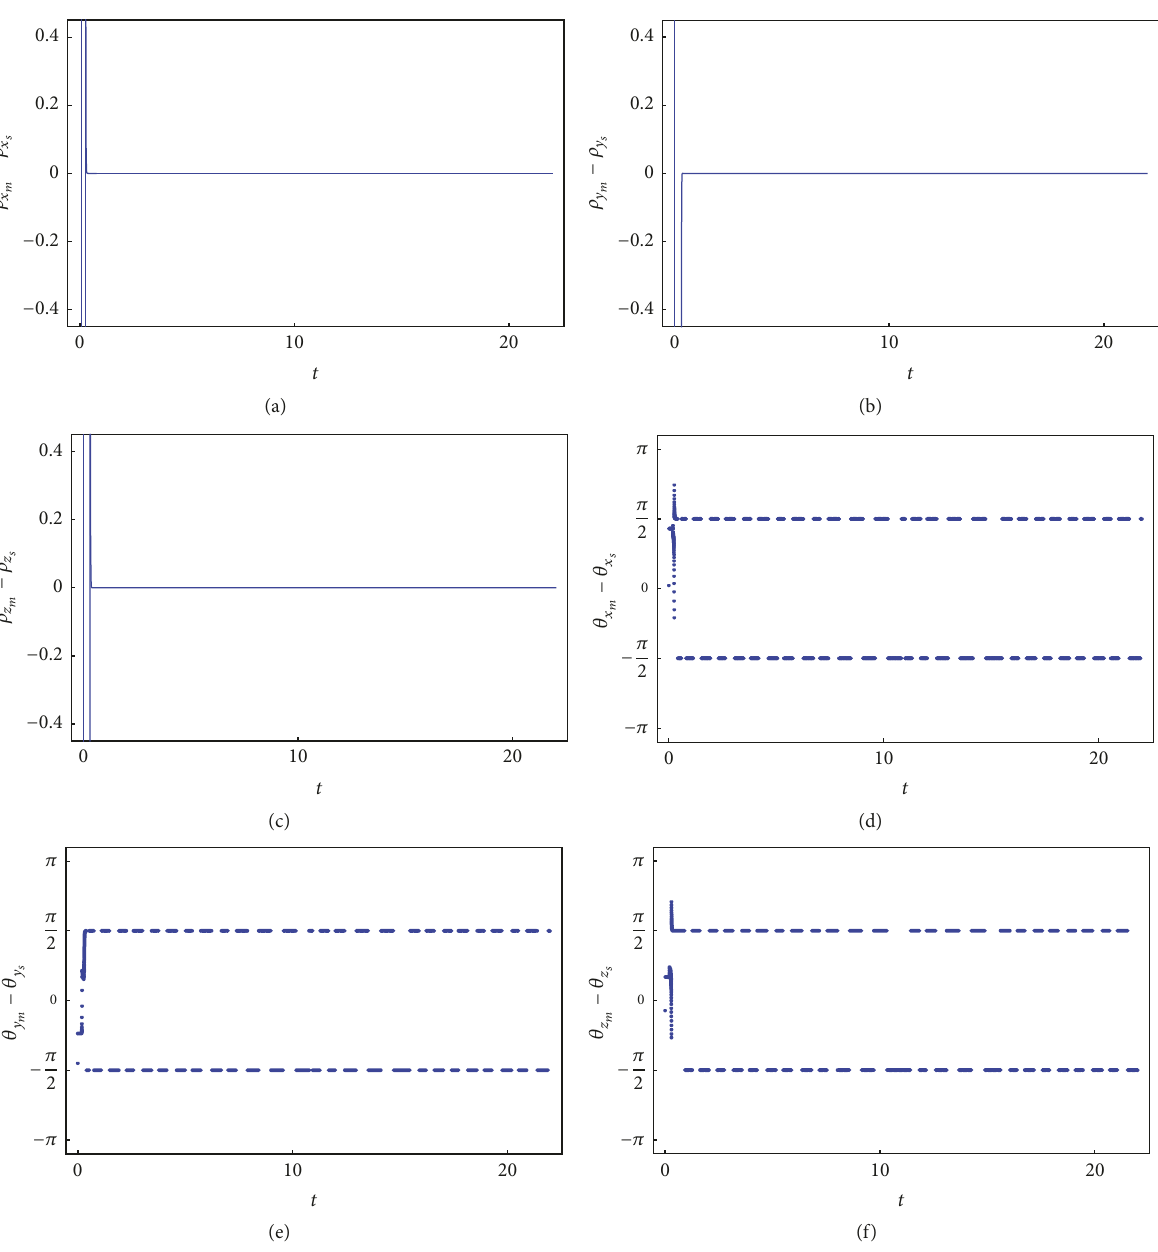
𝑡. (b) 𝜌 − 𝜌 𝑦 𝑚 𝑦 𝑠 versus